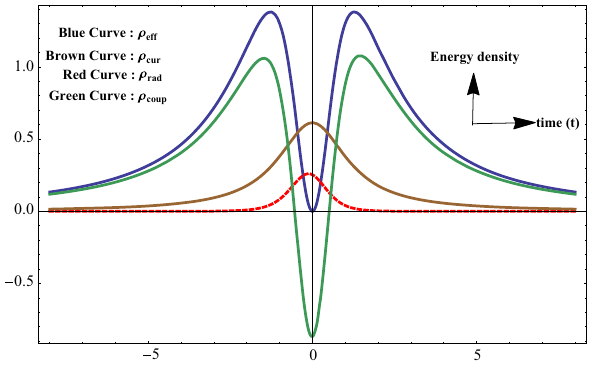
Blue Curve : eff Brown Curve : cur Red Curve : rad Green Curve : coup